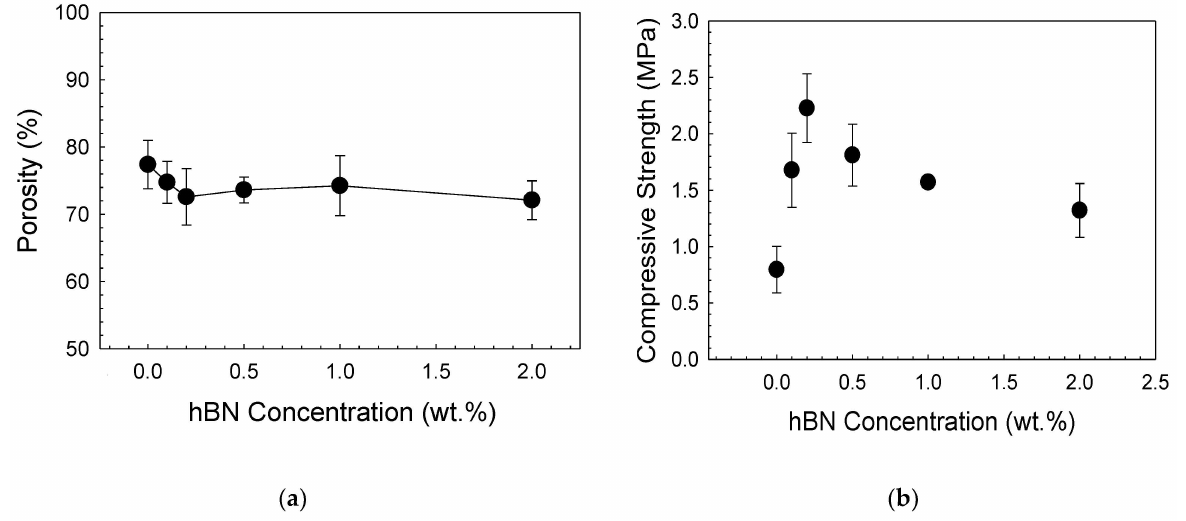
Figure 4. Graphs showing ( a ) the total porosity and ( b ) the compressive strength of the composite